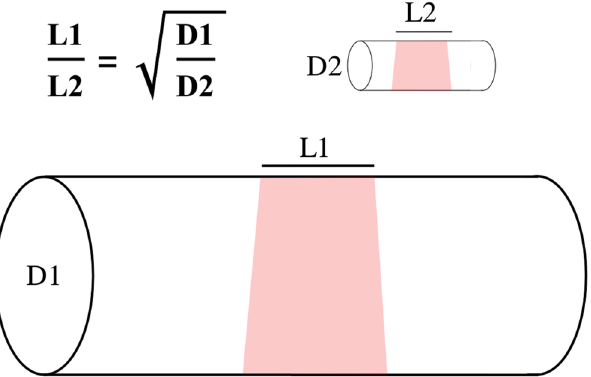
Figure 1. Schematic of the scaling of treatments applied along the surface of an axon. A mathematical analysis (see Supplement, Section 1) demonstrates that the equivalent length of a treatment applied along an axon’s surface scales as the ratio of the square root of the axon diameter. In the illustration shown, D1, diameter of the larger axon, is four times D2, the diameter of the smaller axon, and thus the equivalent effect on the large axon (L1) is twice as long as that needed to affect the smaller diameter axon (L2). This implies that less radiant exposure would be required to block the smaller-diameter axon than the larger-diameter